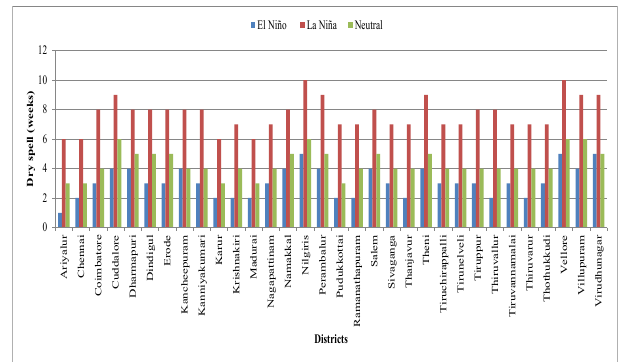
Figure 3. ENSO Effect on dry spell in different districts of Tamil Nadu More number of wet spells under El Niño conditions might be due to the El Niño induced robust activity of monsoon (North East Monsoon) wind pattern that strongly influence the formation of rain-bearing cloud bands over southern peninsular India (Zubair and Ropelewski,